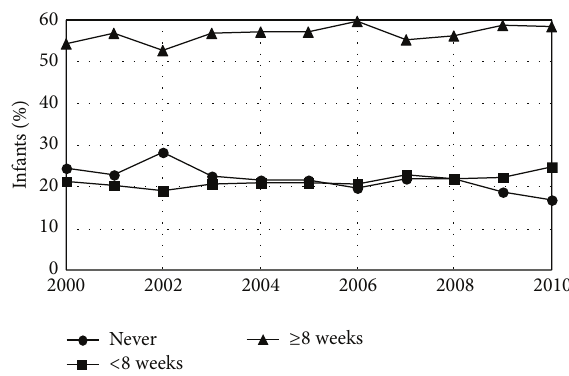
Figure 8: Fraction of infants breast-fed in Maine by year. The fraction never breast-fed declined while the fractions beast-fed for < 8wks and ≥ 8wks increased. Healthy People 2020 has the objective of increasing the number of infants ever breast-fed to 81.9%. Maine does not currently meet this goal but is moving toward